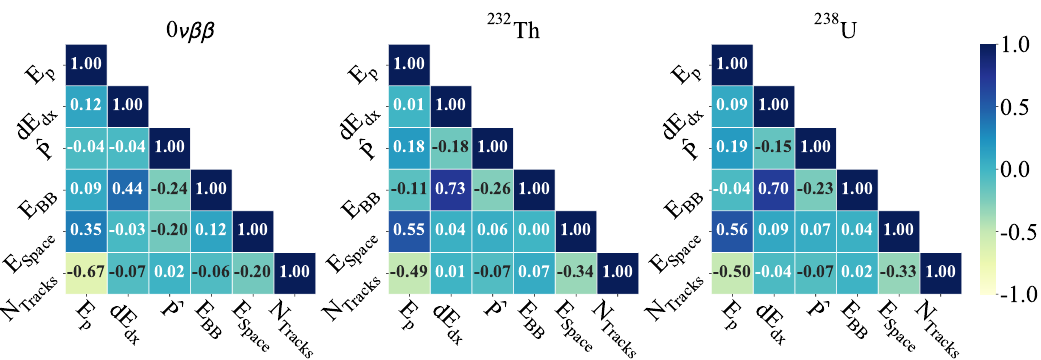
Figure 3. Pearson correlation maps of all the parameters for 0 νββ signal (left), 232 Th (center), and 238 U (right), respectively. The detector configurations is (1 mm, 3%).